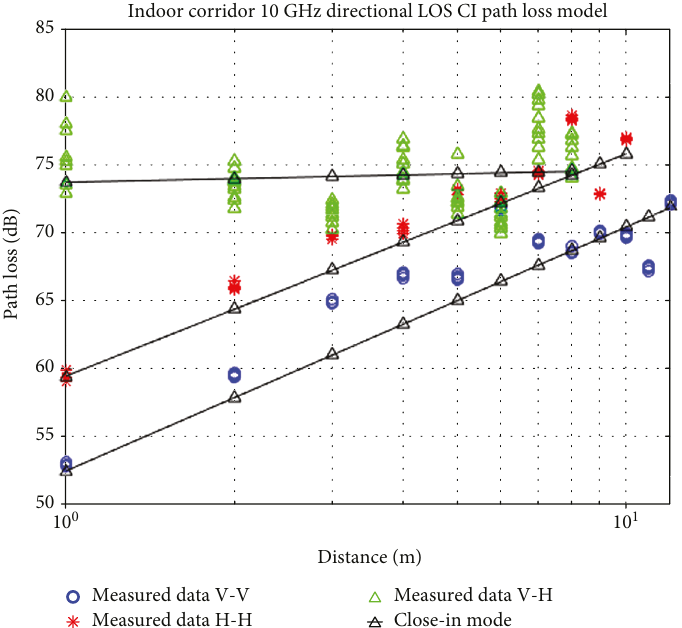
Figure 3: 10 GHz directional LOS large-scale CI path loss model with copolarization V-V, H-H, and V-H in the corridor.